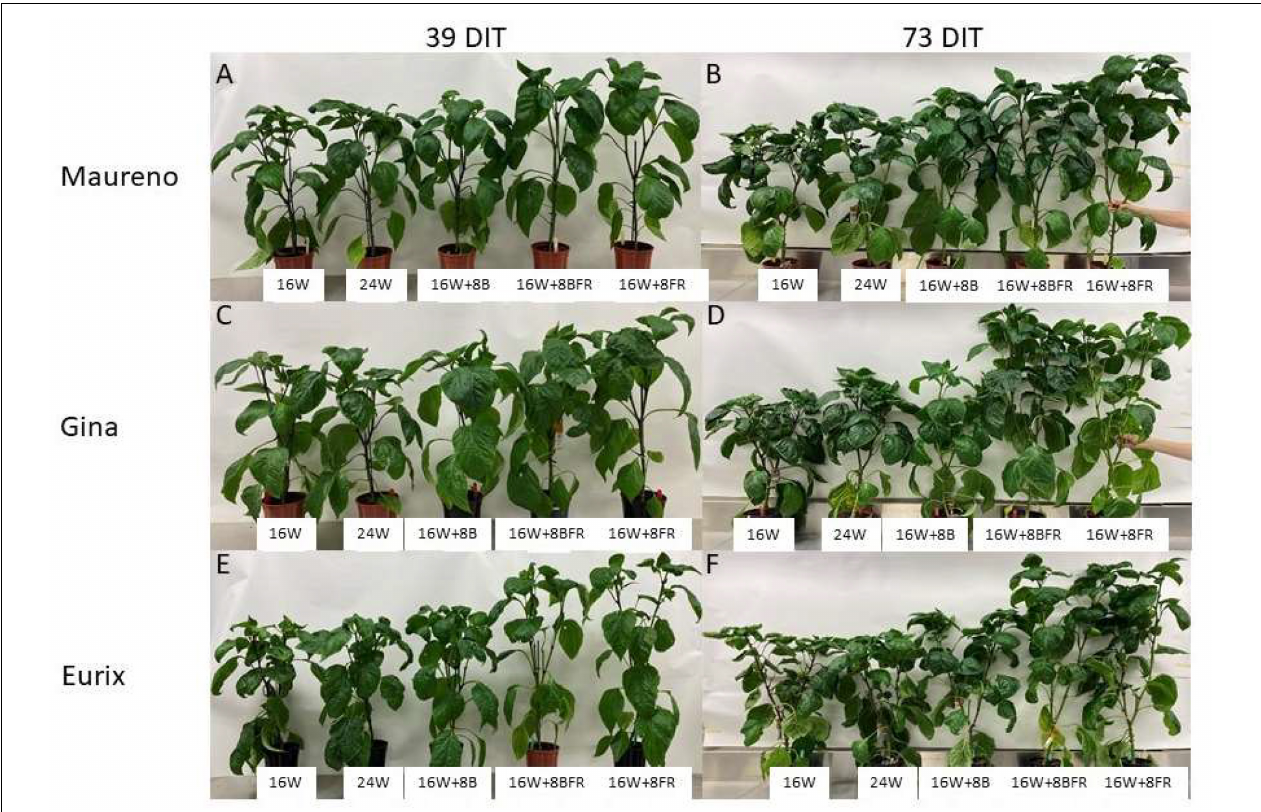
FIGURE 8 | Pepper plants cv. ‘Maureno’ (A,B) , ‘Gina’ (C,D) , and ‘Eurix’ (E,F) grown under five different light treatments at 39 DIT (A,C,E) and 73 DIT (B,D,F) from experiment